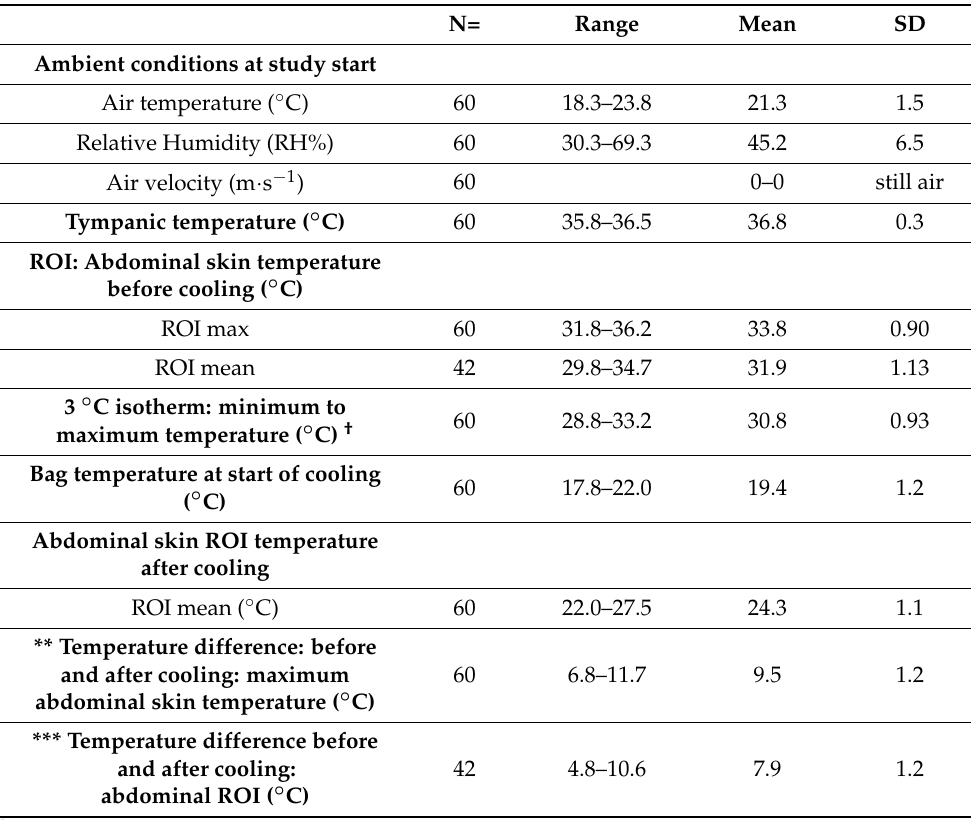
Table 1. Cont. Factor/Parameter Frequency (Valid %) Range Mean (SD) Number of women who 16 (42%) had a C-section birth Co-morbid conditions CVD ** 0 Diabetes 2 (3.3) Smokes 2 (3.3) * measured at the level of the umbilicus, ** CVD, Cardiovascular Disease. The environmental temperature of the clinical room was relatively constant during winter to summer months of the study (Table 2). After 15 min acclimatisation, the exposed abdominal temperature ranged from 29.8–34.7 ◦ C. Application of cold challenge (via water cooled plastic ‘bag’) reduced skin temperature by approximately 5–10 ◦ C over a duration of 90–180 min (n = 45 women cooled for 120 s; n = 12 cooled for 90 s, n = 3 cooled for 180 s). During the first 5 min of the 10 min DIRT video recordings, the number of marked hot spots totalled 1112, individual count ranging from 2–51 (mean 18) spots (Figure 5). Hot spot count for 60 participants at the 1 min timepoint: 0–16 (mean 2.8, SD 3.4); at 2 min, 0–26 (mean 6.3, SD 5.7); at 3 min, 1–42 (mean 10.8, 8SD 8.6); at 4 min, 1–51 (mean 14.9 SD 10.5) and at 5 min, 2–51 (mean 18.5 SD 12.0). Table 2. Environmental conditions, body and skin temperature variables before and after ther- mal